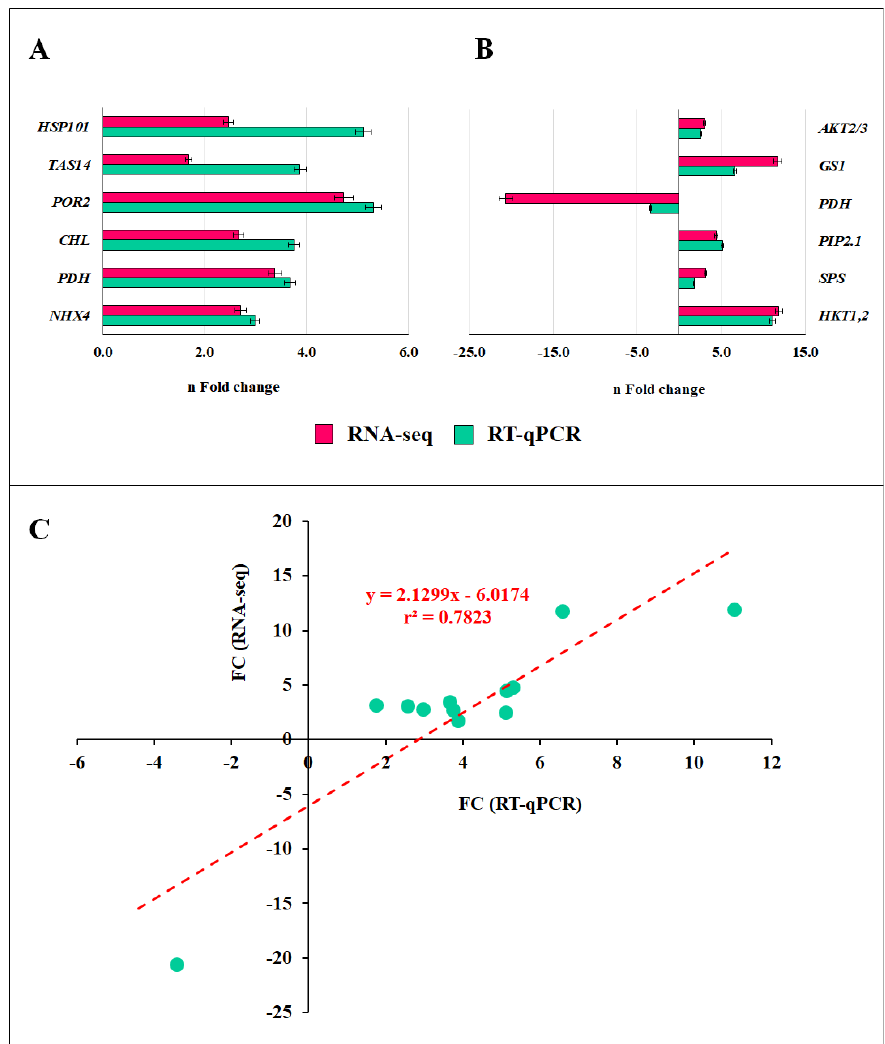
Figure 6. Validation of expression levels of DEGs obtained with RNA-seq using RT-qPCR. ( A ) FC comparative in young leaf tissue DEGs; ( B ) FC comparative in root tissue DEGs; ( C ) linear correlation between RT-qPCR and RNA-seq data.